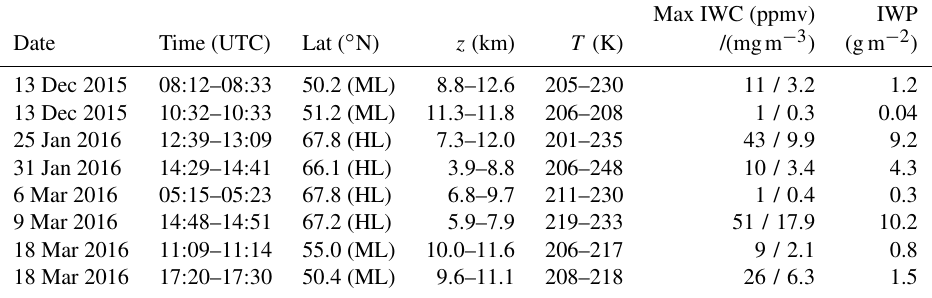
Figure 4. Statistics on the distribution of cirrus sampling below 235K during POLSTRACC at high latitudes north of 60 ◦ N. (a) Distribution over distance to tropopause (given in kelvin, K, of potential temperature) and the squared Brunt–Väisälä frequency ( N 2 ). The temperature is indicated using colour coding. (b) The marginal distribution of N 2 . (c) The distribution of potential vorticity. Cirrus sampling is shown using grey bars, and the total campaign flight time (divided by 10) is shown using the black line. Table 1. List of complete cirrus profiles sampled during the POLSTRACC aircraft campaign. The given latitude is an average value for the profile. The acronyms ML and HL are used to categorise the profiles as middle- or high-latitude profiles respectively. z denotes the vertical span, T is the temperature range and the maximum IWC (in molar mixing ratio and in mass concentration) is read from the WARAN measurements. The ice water path (IWP) is calculated by integrating the IWC measurements over the whole profile. Max IWC (ppmv)